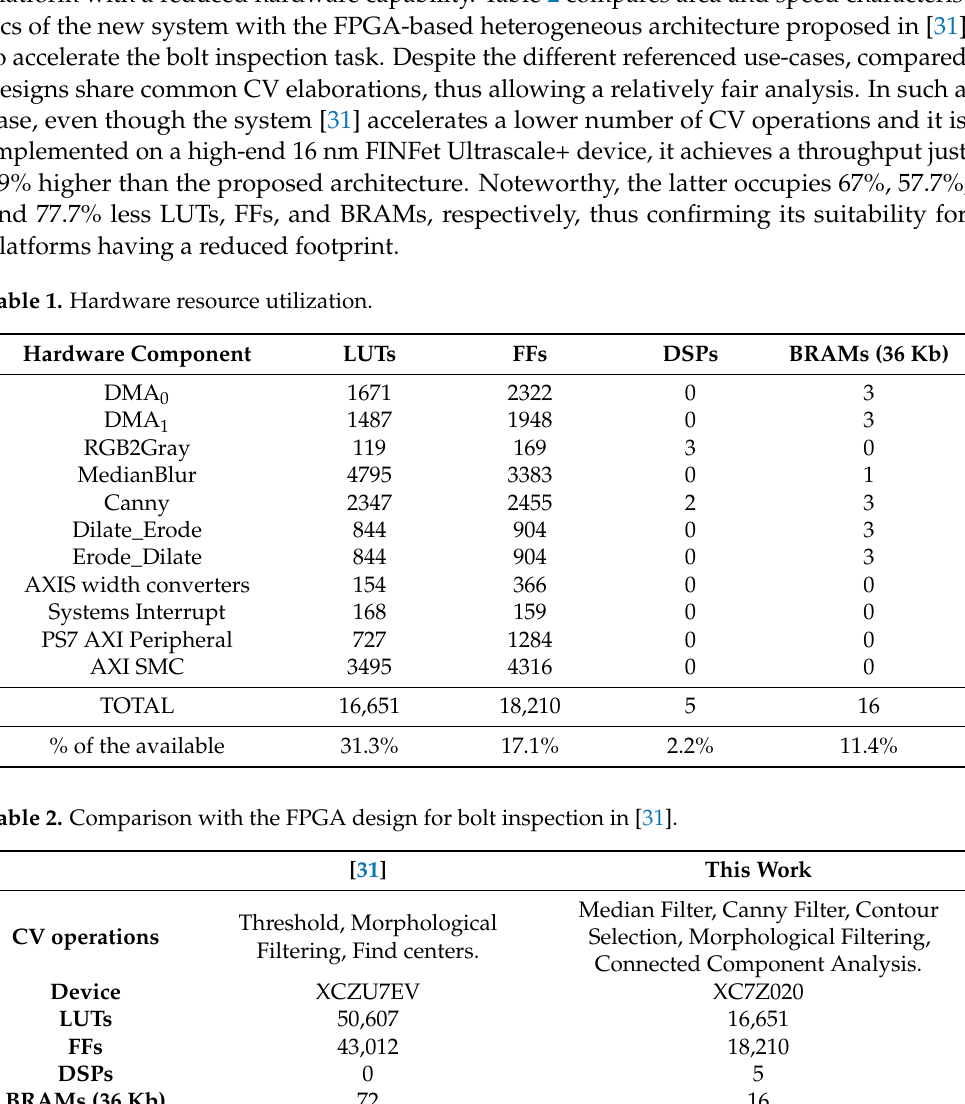
Figure 16. ( a ) The integration of the proposed embedded system into the quality cell and ( b ) a phase of the testing procedure.